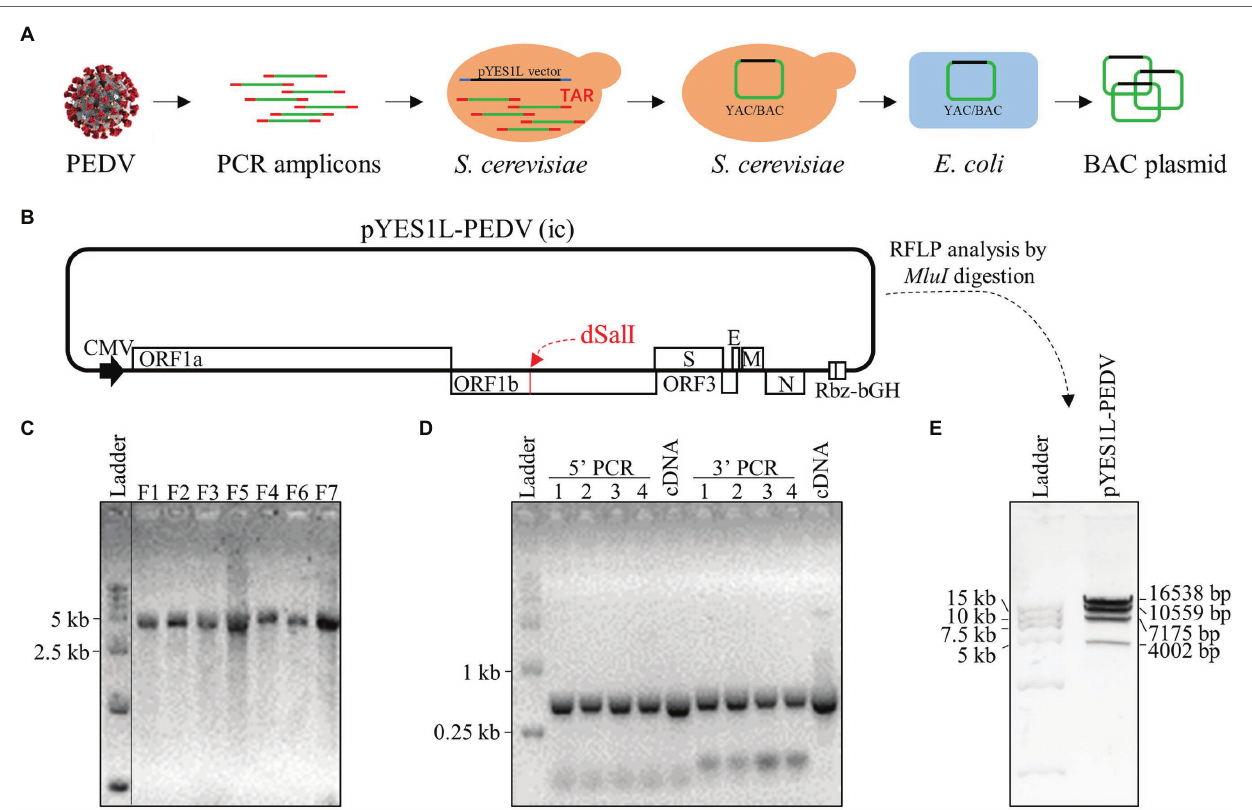
FIGURE 2 | Construction of a PEDV infectious cDNA clone by homologous recombination in yeast . (A) The procedure of PEDV infectious cDNA clone assembly. Briefly, the complete PEDV genome was divided into seven fragments, and the neighboring fragments share at least 30 nucleotides overlapping regions. Together with a linearized vector (pYES1L) all seven cDNA fragments were transformed into Yeast MaV203 competent cells, and the full-length cDNA clone was assembled by transformation-associated recombination (TAR) in yeast. The yeast colonies were screened by colony PCR targeting the junction regions. The full-length cDNA clone was extracted from the positive colony and electroporated into DH10B Escherichia coli . Competent cells. Finally, the full-length PEDV cDNA clone in E. coli . Was purified using a Plasmid Midiprep Kit (MACHEREY-NAGEL). (B) A schematic diagram of PEDV infectious cDNA clone. In this YAC/BAC vector-based infectious cDNA clone, a CMV early promoter and a hepatitis D virus ribozyme (Rbz) followed by a BGH termination signal were added at 5 ' and 3 ' end of viral genomic cDNA, respectively. (C) Agarose gel electrophoresis of seven cDNA fragments covering the complete genome of PEDV HM strain. The complete genome of PEDV HM was amplified by RT-PCR with the Q5 high-fidelity DNA polymerase (NEB) using primers listed in Table 1 . The gel-purified PCR products were separated in 1% agarose gel. (D) Colony PCR screening of positive clones. Five yeast colonies grew on CSM-Trp agar plate were picked for colony PCR using two pairs of primers ( Table 1 ) targeting the junction regions of the 5 ' end and 3 ' end of the PEDV genome. (E) Restriction fragment length polymorphism analysis of the PEDV cDNA clone. The cDNA clone pYES1L-PEDV digested with MluI restriction enzyme was separated in 0.8% agarose gel. Four DNA fragments were observed at the predicted sizes of 16,538, 10,559, 7,175, and 4,002